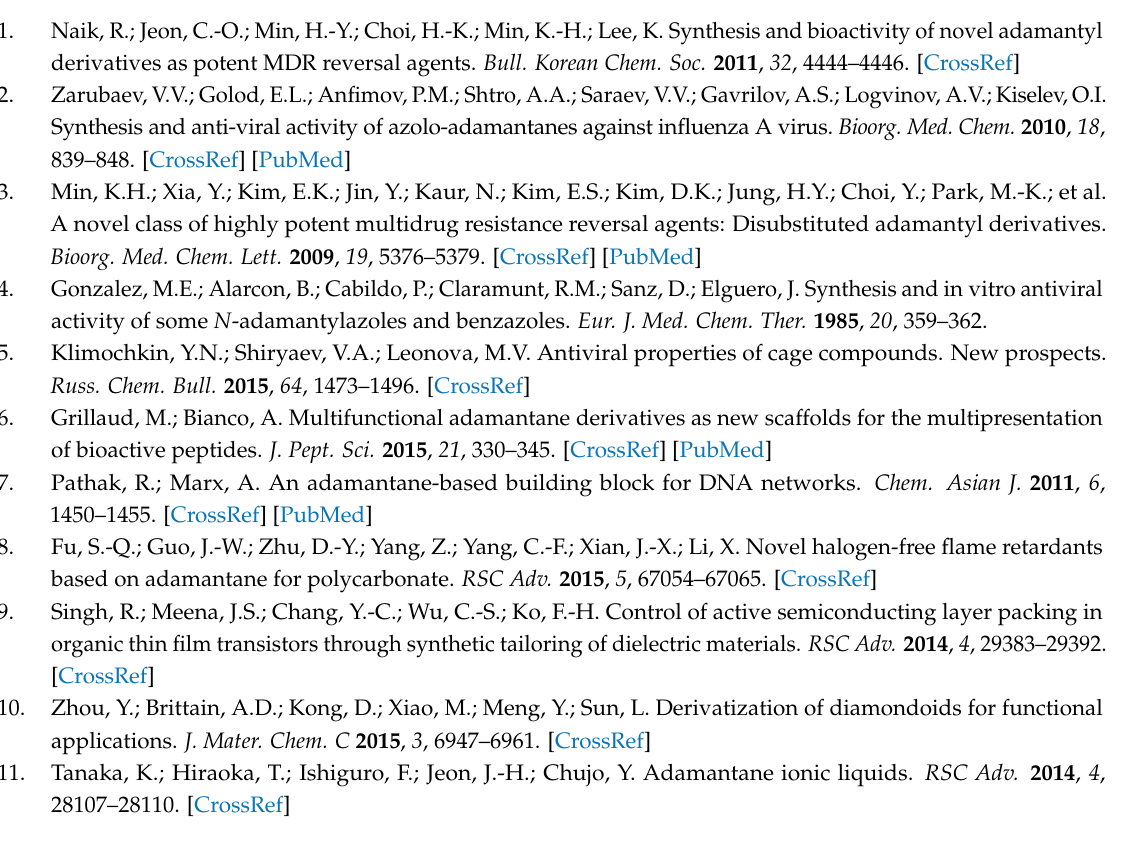
Supplementary Materials: The following are available online. Figure S1: Numbering scheme of 1,3-bis(1,2,4- triazol-1-yl)adamantane ( 1 ) and 1-(1,2,4-triazol-1-yl)-3-(1,2,4-triazol-4-yl)adamantane ( 2 ); Figure S2: Gas chromatogram of product mixture of the reaction between 1,3-dibromoadamantane and 1,2,4-triazole; Figure S3: Electron-impact mass-spectra of 1,3-bis(1,2,4-triazol-1-yl)adamantane ( a ), 1-(1,2,4-triazol-1-yl)-3-(1,2,4-triazol-4- yl)adamantane ( b ) and 1-(1,2,4-triazol-1-yl)-3-bromoadamantane ( c ); Figure S4: 1 H-NMR spectrum of 1,3- bis(1,2,4- triazol-1-yl)adamantane ( 1 ); Figure S5: 13 C-NMR spectrum of 1,3-bis(1,2,4-triazol-1-yl)adamantane ( 1 ); Figure S6: 1 H-NMR spectrum of 1-(1,2,4-triazol-1-yl)-3-(1,2,4-triazol-4-yl)adamantane ( 2 ); Figure S7: 13 C-NMR spectrum